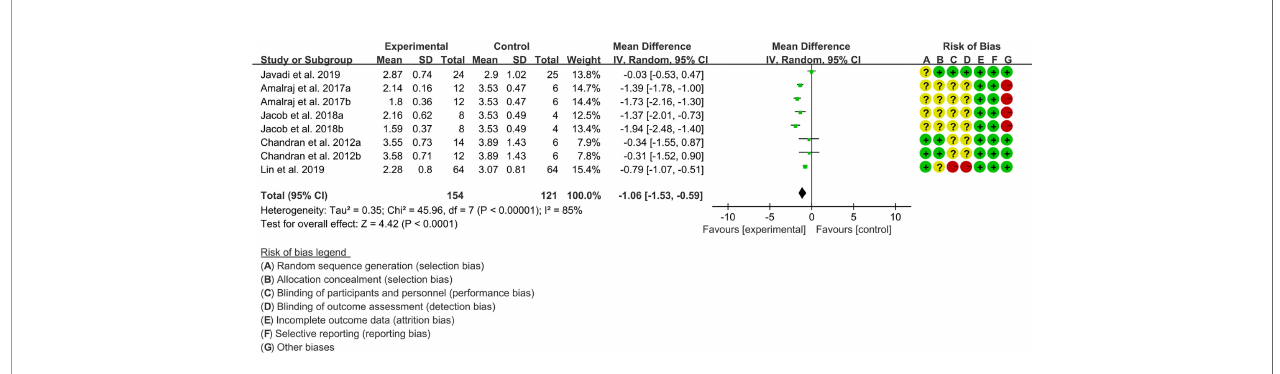
FIGURE 3 | The results of DAS28.